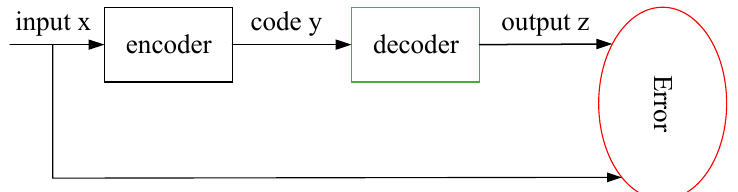
Figure 3. The diagram of the training process with unlabeled samples.